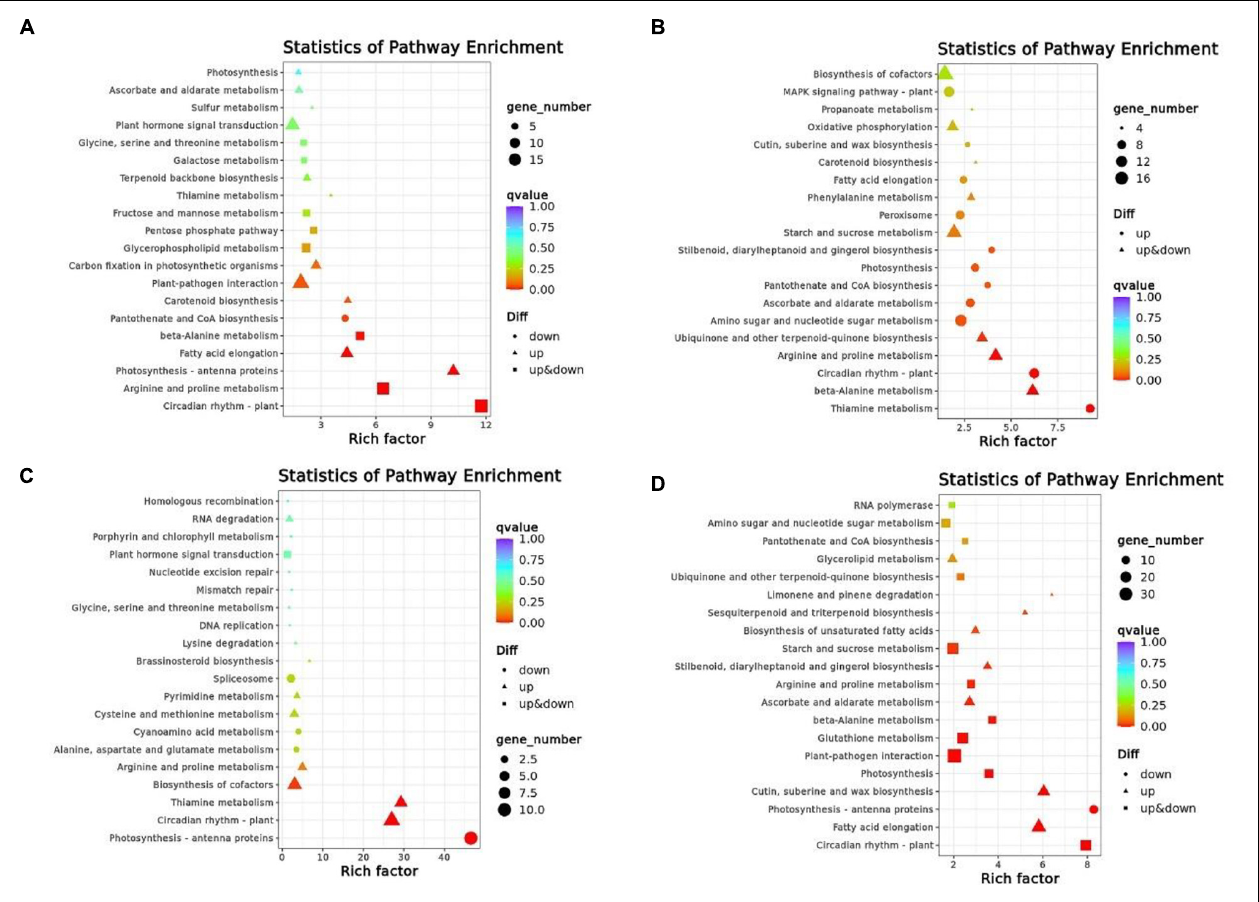
FIGURE 5 | A scattered plot of the KEGG pathway for DEGs in each of the comparison group [ (A) XMCK-XMT1, (B) XMCK-XMT2, (C) YNCK-YNT1, and (D) YNCK-YNT2]. Each circle in the figure represents a KEGG pathway. The ordinate represents the pathway name, and the horizontal axis represents enrichment factor, the ratio of the proportion of differential genes annotated to this pathway relative to the proportion of genes annotated to this pathway in all genes. Enrichment level of DEGs in this pathway is more significant when the enrichment factor is high. The color of the circle represents q -value, which was the P -value corrected by multiple hypothesis testing. DEGs in this pathway have better enrichment significance when the q -value is smaller. Each circle indicates the number of genes enriched in the pathway, and the larger the circle, the more genes. XMCK, Xinmai26 was treated at 16 ◦ C; XMT1, Xinmai26 was treated at 4 ◦ C for 4 h; XMT2, Xinmai26 was treated at − 4 ◦ C for 4 h; YNCK, Yannong19 was treated at 16 ◦ C; YNT1, Yannong19 was treated at 4 ◦ C for 4 h; YNT2, Yannong19 was treated at − 4 ◦ C for 4